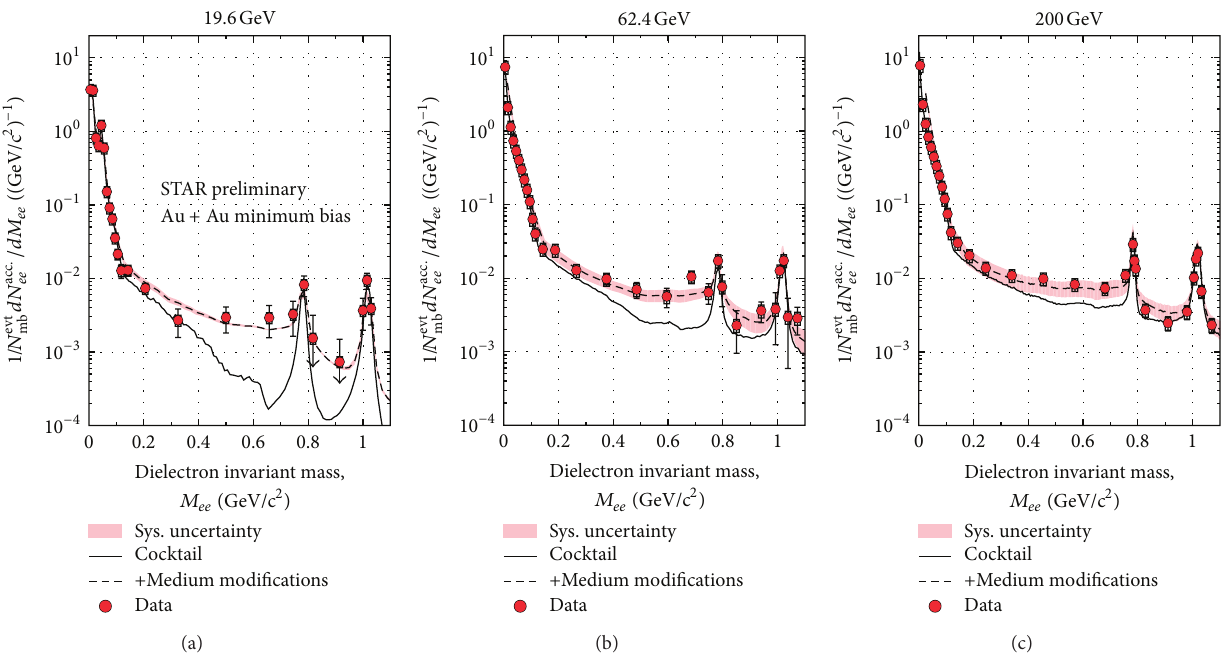
Figure 9: Low-mass dilepton spectra as measured by STAR in the RHIC beam-energy scan [68]; MB spectra are compared to theoretical predictions for the in-medium hadronic + QGP radiation, added to the cocktail contribution.